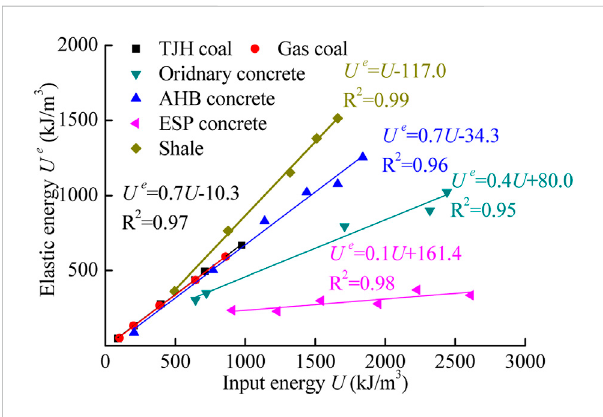
FIGURE 13 Relationshipbetween U e and U .Sources:shale,Imanetal.(2018); TJH coal, Liu S M et al. (2020); gas coal, Gong et al. (2020); and ordinary, ESP, and AHB concrete, Lu et al.